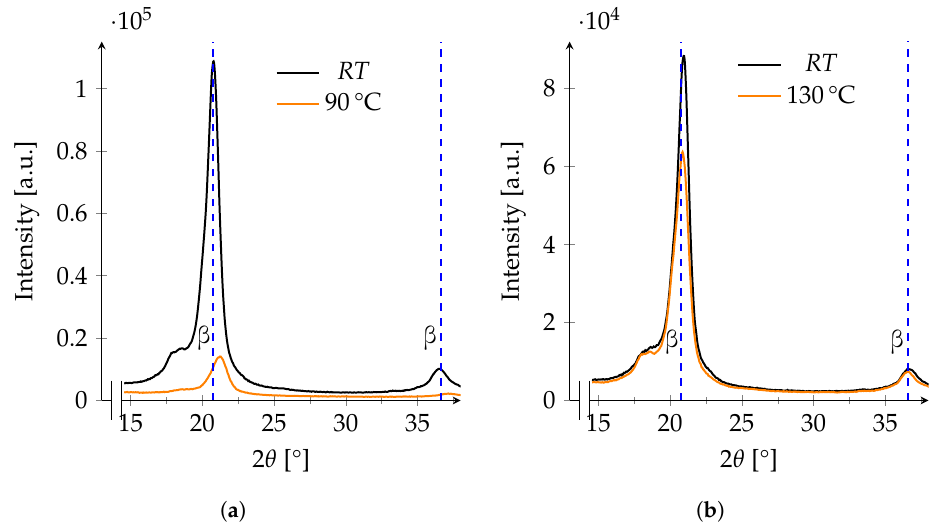
Figure 6. XRD patterns of two films annealed at 90°C ( a ) and at 130°C ( b ) before and after annealing. The blue dashed lines at 20.75° and 36.6° refer to the expected main reflections of the β -phase. The sample annealed at 160 °C shows an increase in intensity after annealing. The re- flections of the α -phase are more visible, and the peak of the β -phase shifts from 21.1° to 20.8° (Figure 7).